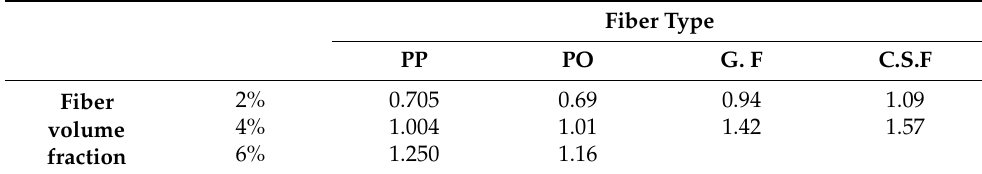
Table 9. Values of β factors from the experimental test results.